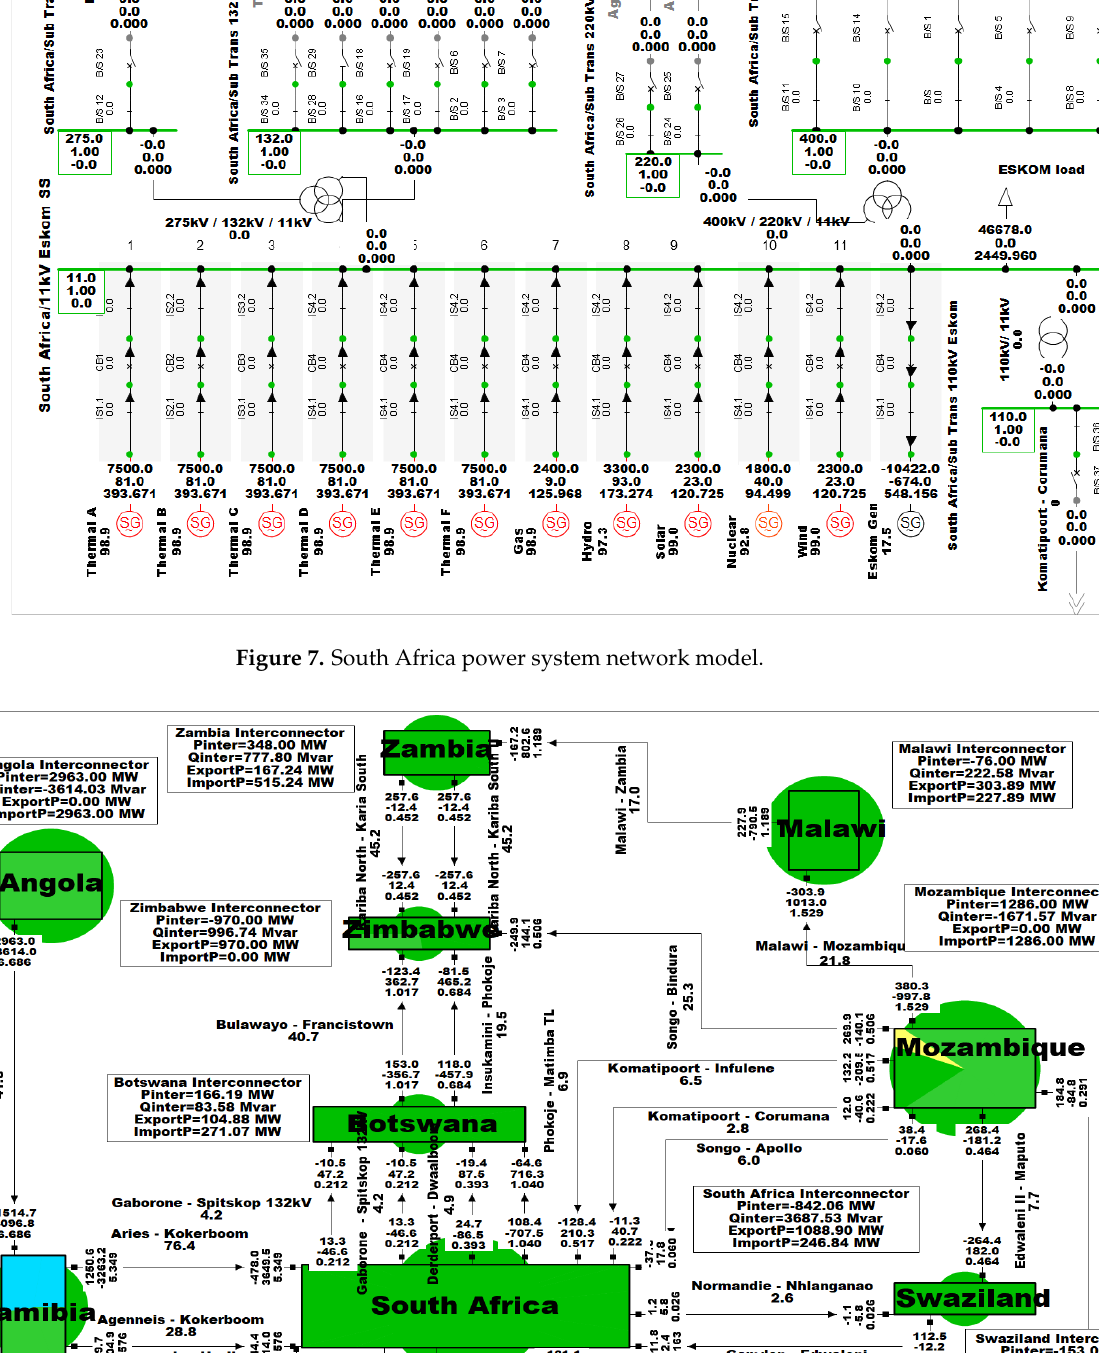
Figure 8. Southern African regional grid network model.